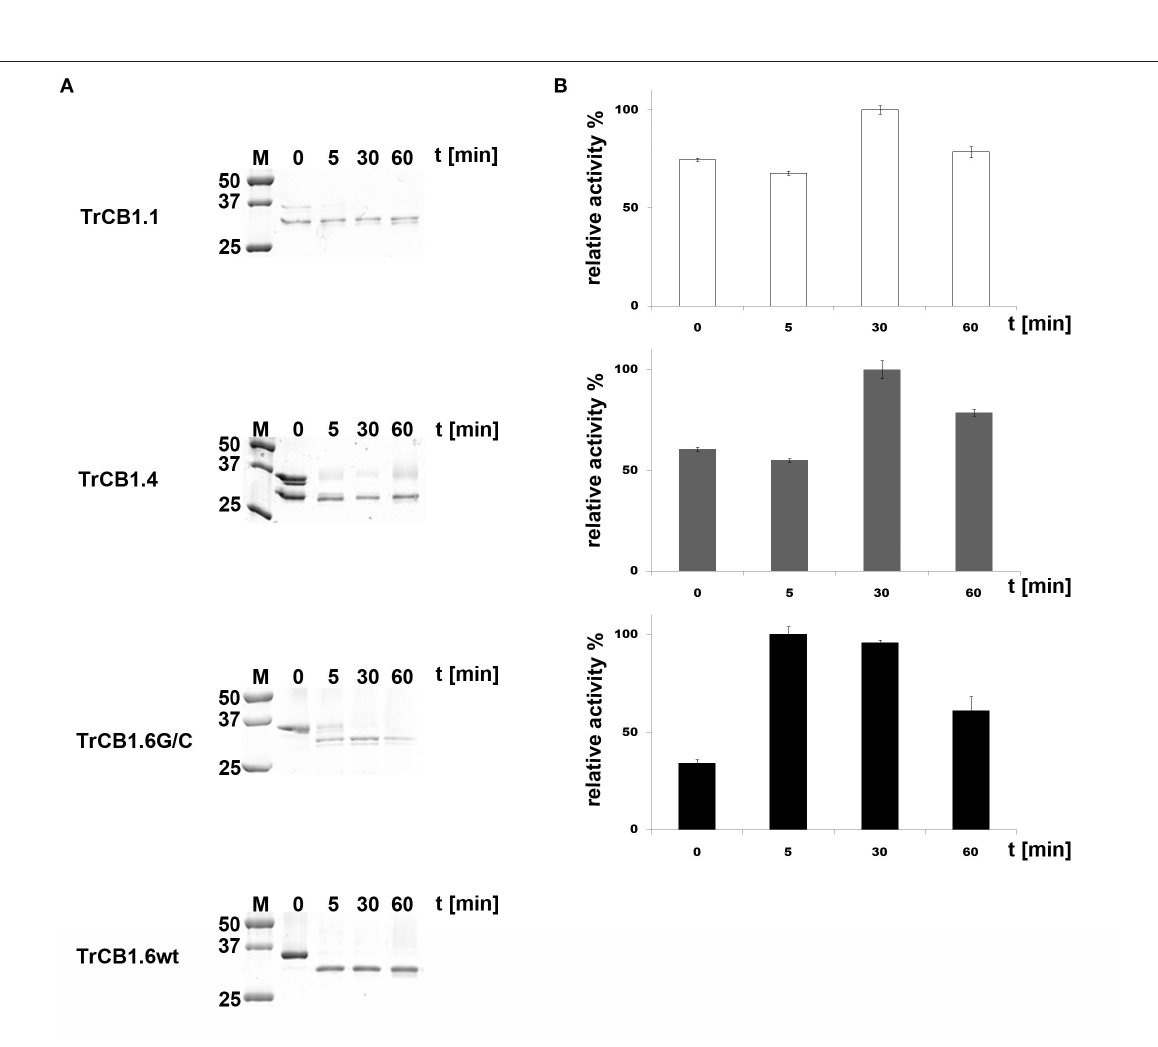
Frontiers in Cellular and Infection Microbiology |